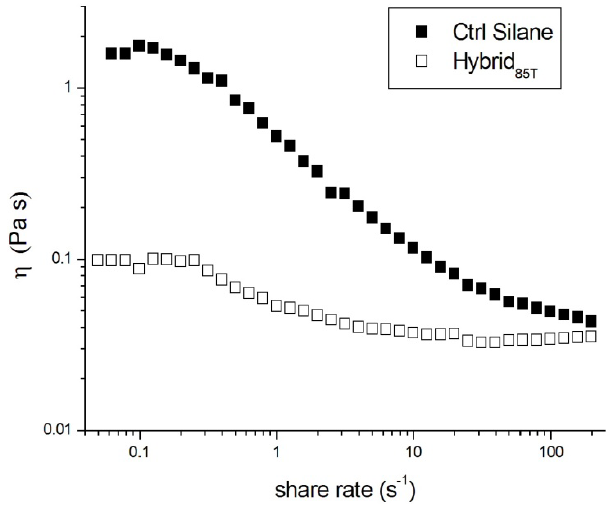
formulations. 85T